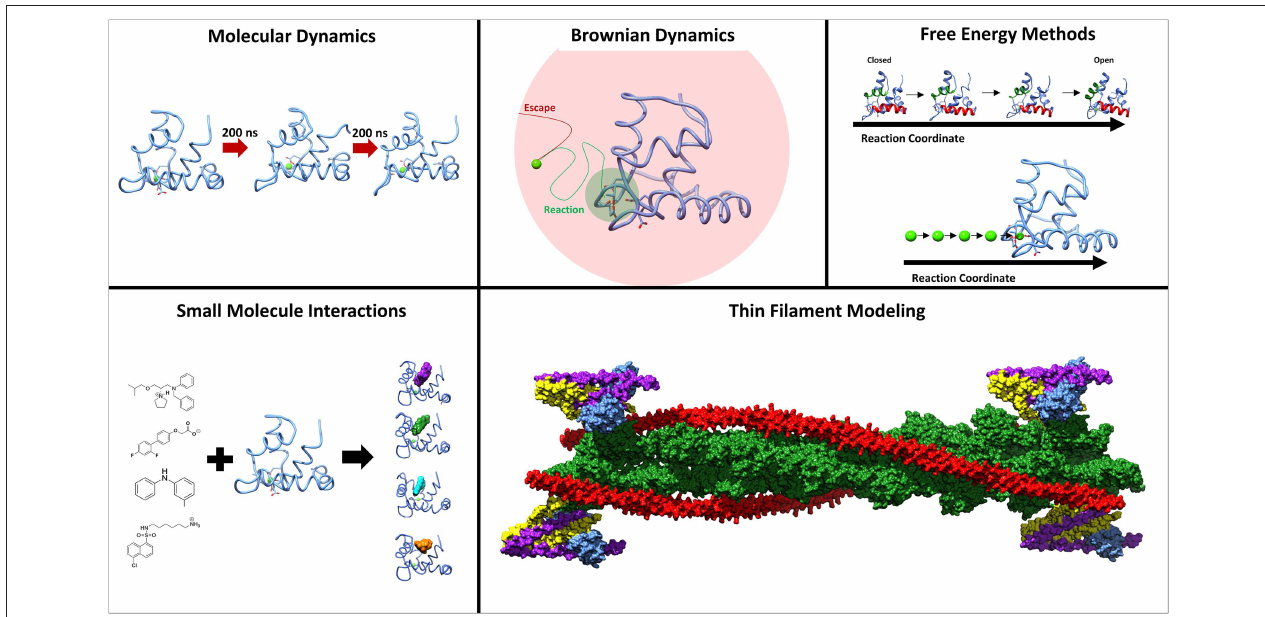
FIGURE 1 | Methods employed to study the underlying molecular mechanisms of muscle contraction. Molecular dynamics and umbrella sampling have been used to study the dynamics of the hydrophobic patch region. Techniques such as BrownDye and umbrella sampling have been used to study calcium binding. Small molecules have been studied interacting with troponin C through docking and molecular dynamics. Thin filament modeling has been key to understand the larger context of muscle